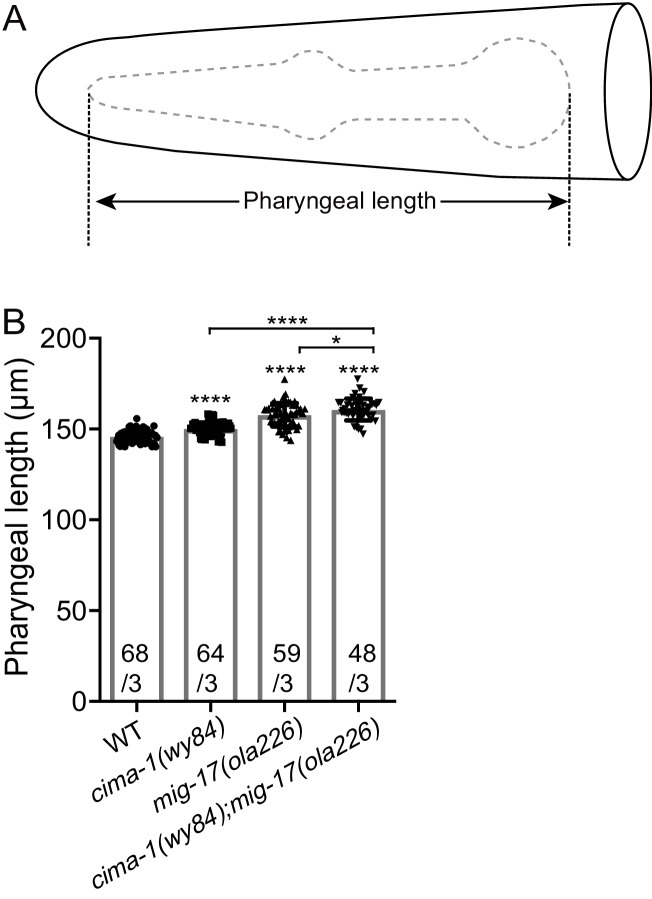
mig-17(ola226) and cima-1(wy84) phenotypes in pharyngeal length.(A) A cartoon diagram of the pharynx in the C. elegans head. The pharynx is outlined with a dashed grey line, and the length quantified in (B) is shown. (B) Quantification of pharyngeal length of wild type, cima-1(wy84), mig-17(ola226) and cima-1(wy84);mig-17(ola226) double mutants. The data indicate that both cima-1(wy84) and mig-17(ola226) significantly increase the pharyngeal length, consistent with (Shibata et al., 2016), and that the double mutant enhances the single mutant effects. The data indicate that unlike the AIY presynaptic phenotype, mig-17(ola226) and cima-1(wy84) cooperate, rather than antagonize each other, in regulating pharyngeal length. In the graph, the total number of animals (N) and the number of times scored (n) are indicated in each bar for each genotype as N/n. Statistical analyses are based on one-way ANOVA by Tukey’s multiple comparison test. Error bars represent SEM, *p<0.05, ****p<0.0001 compared to wild type or between indicated genotypes.